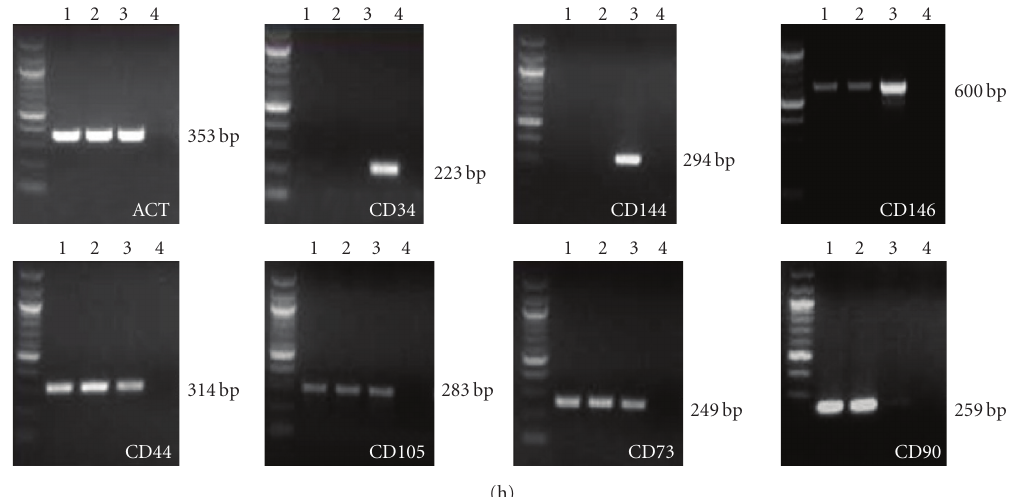
Figure 3: UCSCs demonstrate a high level of ex vivo expansion and retain MSC surface marker phenotype for up to 10 passages, or 5 weeks in culture. (a) UCSCs showed a significantly higher level of proliferation in EGM2 growth medium as compared to DMEM (72 hours, P = .038, 96 hours, P = .10). (b) Cells cultured in the di ff erent media were distinct morphologically; DMEM-cultured cells were significantly larger in 2D as compared to cells grown in EGM2 (mean ± s.e.m.). (c) We expanded UCSCs for more than 55 population doublings, PDs. Thirteen UCSC populations were expanded for 10 passages, and 3 of these UCSC populations were continued for another 10 passages. The theoretical expansion yield is 10 20 cells from an initial 2 × 10 4 cells. (d) Mean population doubling time of the UCSCs was 24 ± 1.1 hours for the populations at 0–10 PDs, 23 ± 1.7 hours at 10–20 PDs, which are significantly faster than the PDT of 28 ± 1.3 hours for UCSCs at 20–30 PDs ( P < .05, bars represent mean ± s.e.m.). (e) We observed no significant changes in cellular division times which was similar for cells at 0–10 PDs (14.8 ± 0.4 hours), 10–20 PDs (15.1 ± 0.7 hours), and 20–30 PDs (15.9 ± 0.8 hours). (f) Histograms are representative of UCSCs surface marker expression 7 days postisolation. The population is homogeneously positive for mesenchymal cell markers